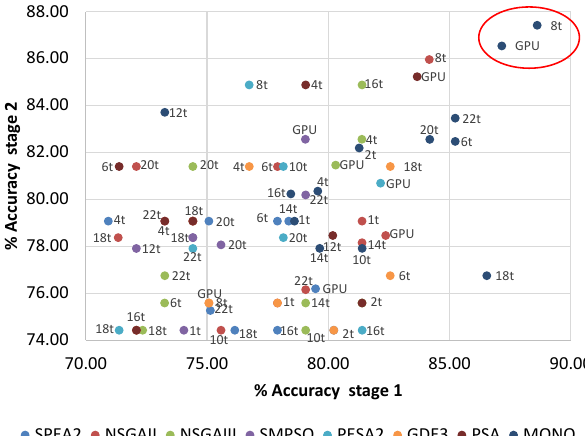
Figure 5. Best points for each thread setting and metaheuristic method.